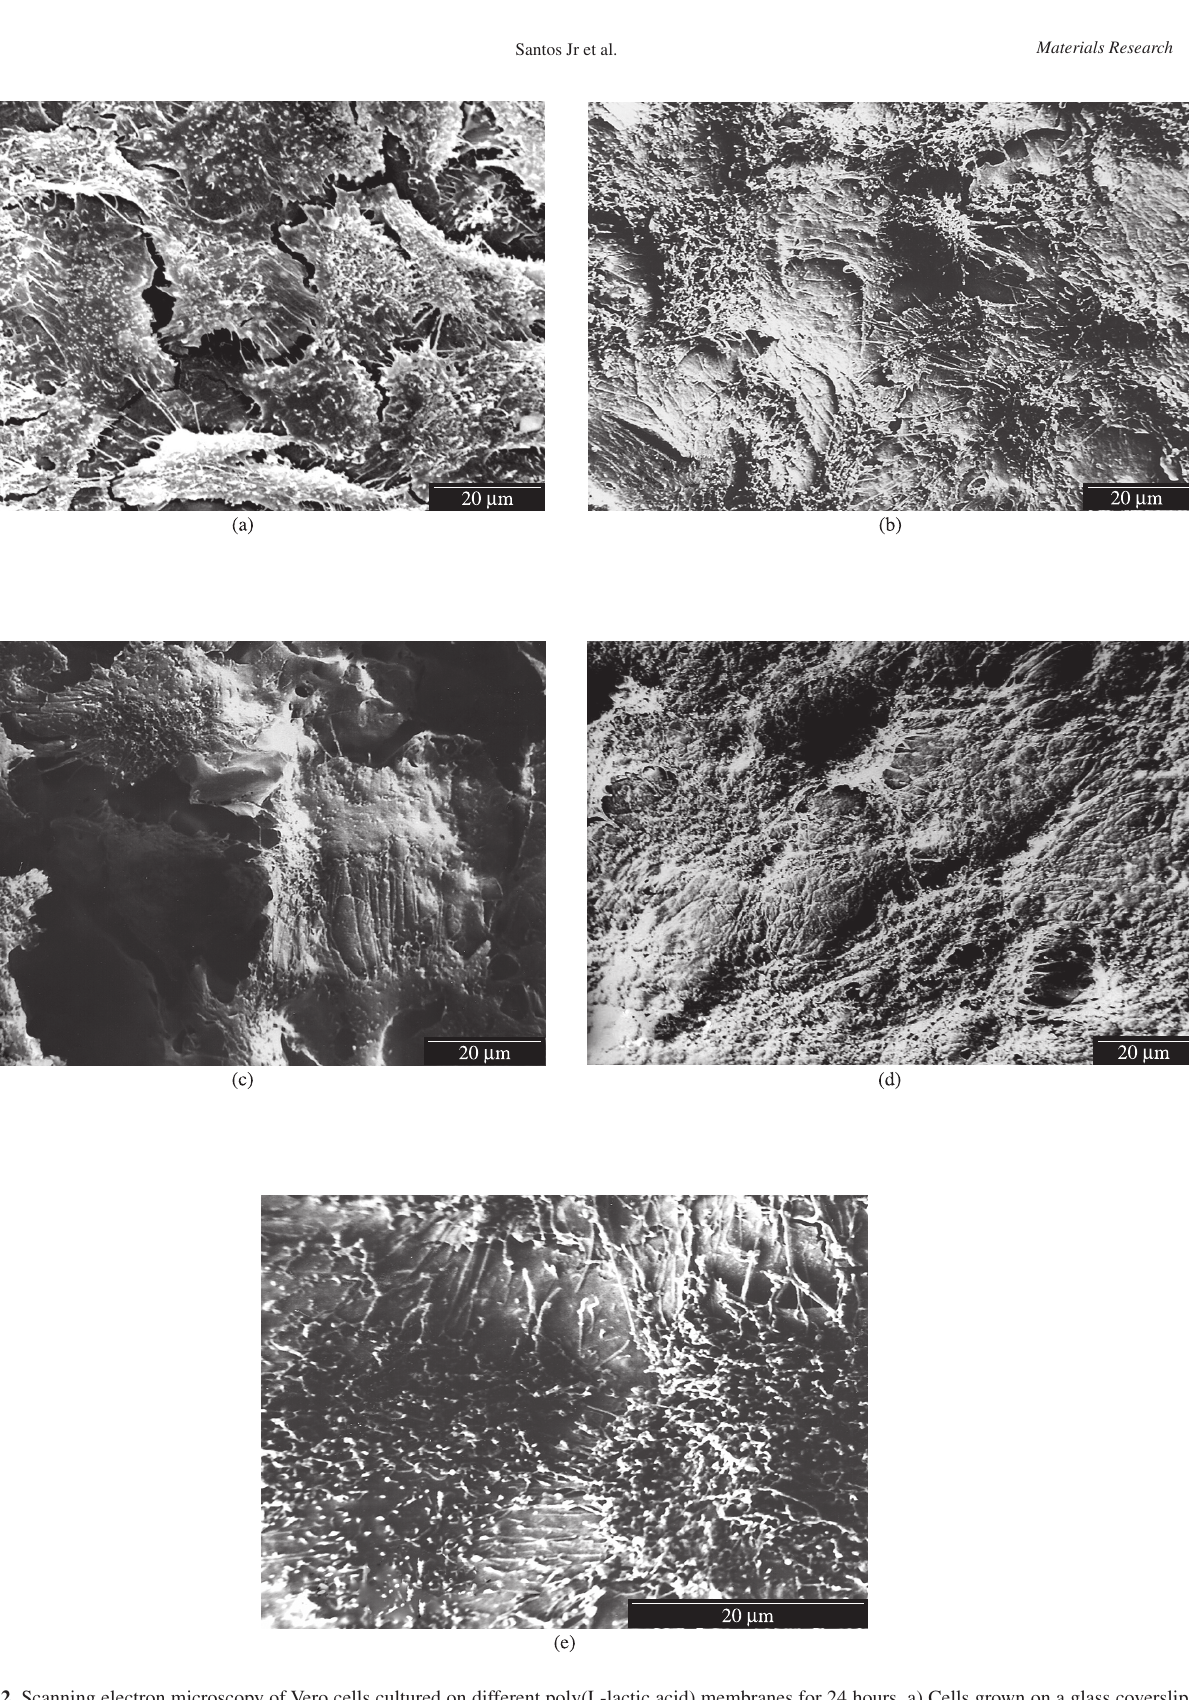
Figure 2. Scanning electron microscopy of Vero cells cultured on different poly(L-lactic acid) membranes for 24 hours. a) Cells grown on a glass coverslip, b) cells grown on a dense membrane (note the cell processes linking the cells to one another), c) cells cultured on a membrane with a pore diameter less than 45 µ m, d) cells cultured on a membrane with a pore diameter of 150-250 µ m, and e) cells cultured on a membrane with a pore diameter of 250-350 µ